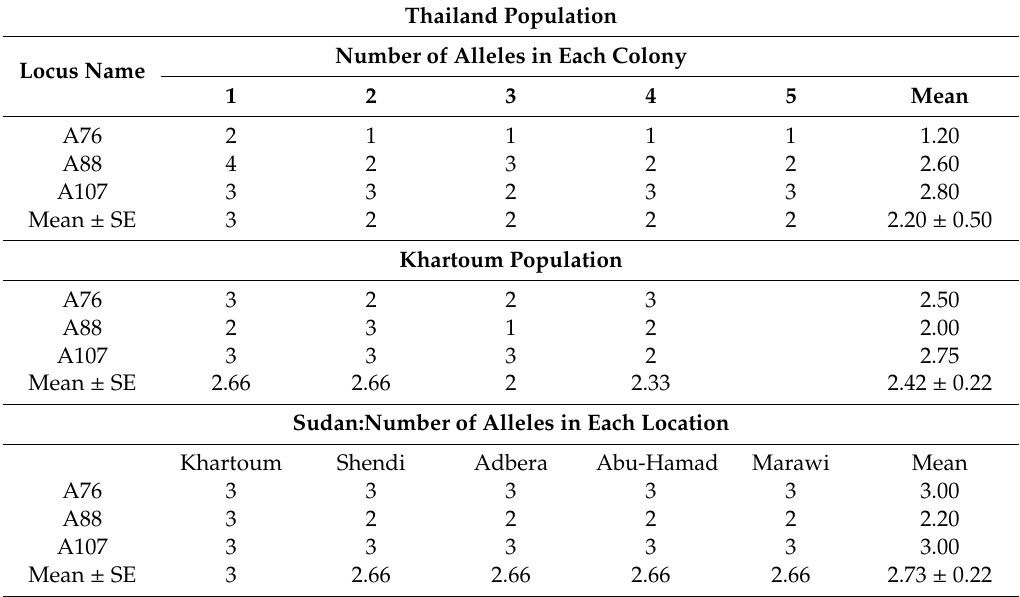
Table 2. Number of alleles in native and introduced colonies of A. florea . The average number of alleles found in the entire population of A. florea in Sudan did not significantly exceed that found in a single colony of A. florea from its original region (data from Thailand obtained from Palmer and Oldroyd [44]). Thailand Population Number of Alleles in Each Locus Name